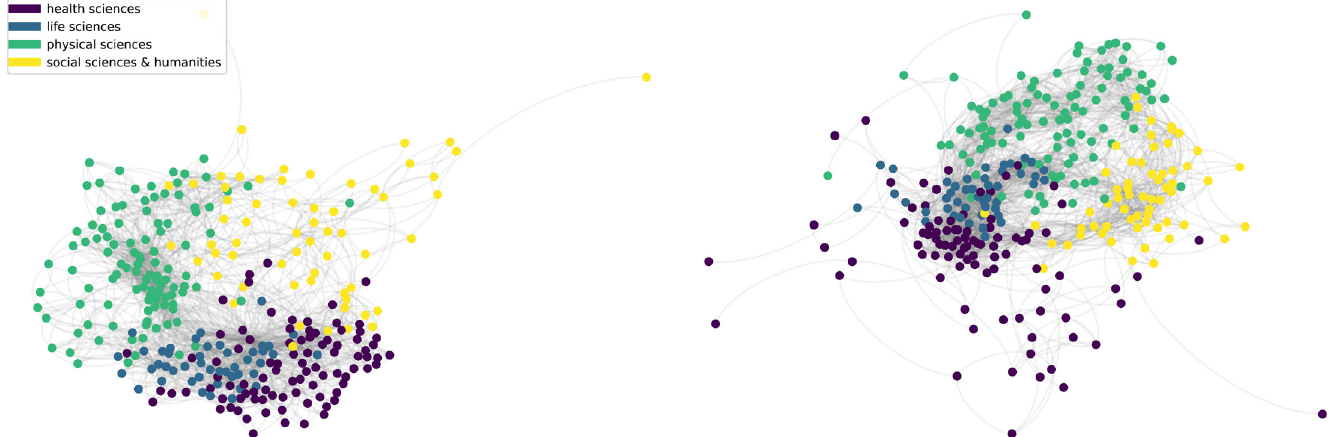
Fig 3. Graphical representations. These networks are created using the publication records in [2000, 2014]. Each node is a research field, color-coded according to the respective macro area. We first include the edges of maximum spanning tree and then add all edges whose weights are above a threshold p arbitrarily chosen for better visualization. Left : Frequentist model, p = 0.212. Right : Embedding model, p = 0.35.